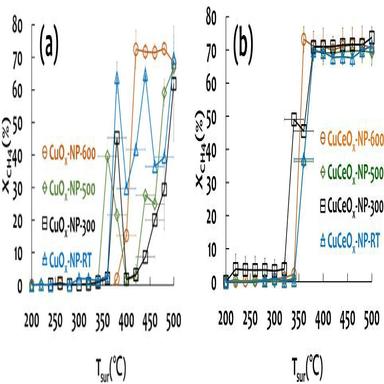
Activity tests of methane combustion catalyzed by Cu-only NP and CuOx-CeO2 hybrid NP over various oxidation states of Cu. (a) Cu-only NP (b) CuOx-CeO2 hybrid NP. Reprinted with permission from Ref. .